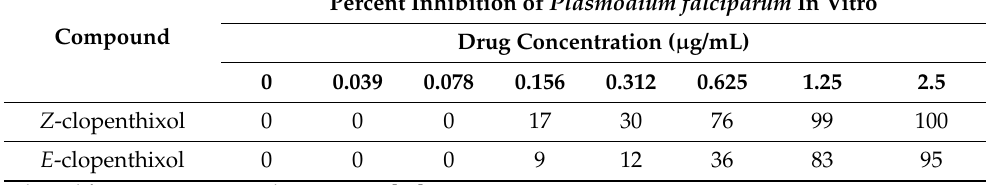
Table 12. Percentage inhibition of 3 H-hypoxanthine uptake in Plasmodium falciparum at various concentrations of Z -clopenthixol and E